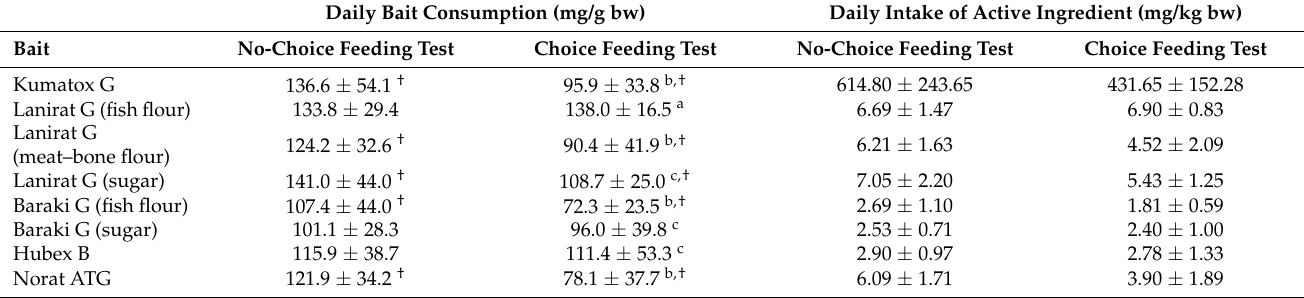
Table 3. Bait and active ingredient dosage intake by house mice in the no-choice and choice feeding tests. Data on active ingredients have to be considered with regard to the nominal concentration in the baits (see under Table 1). Data are presented as means ± SD; significance at the level p < 0.05. Daily Bait Consumption (mg/g